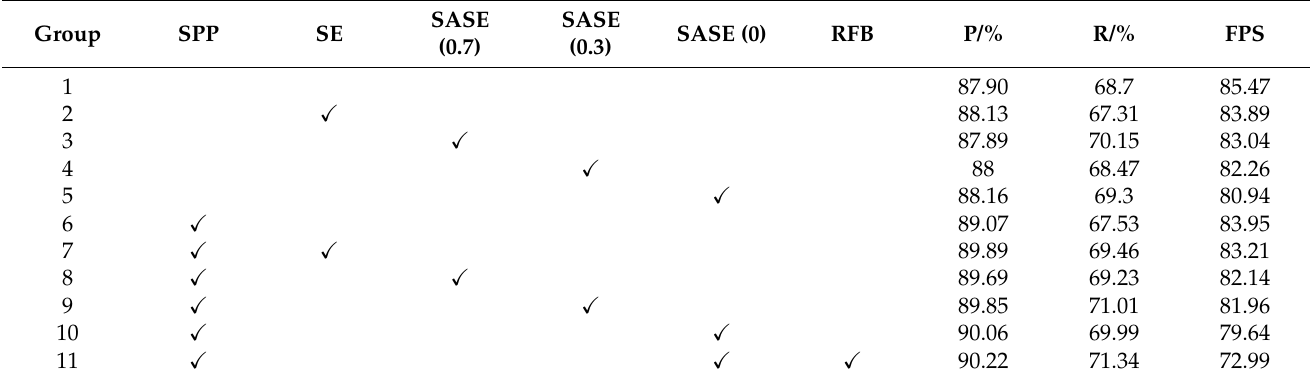
Table 4. Results of ablation experiment, training epoch were 200.